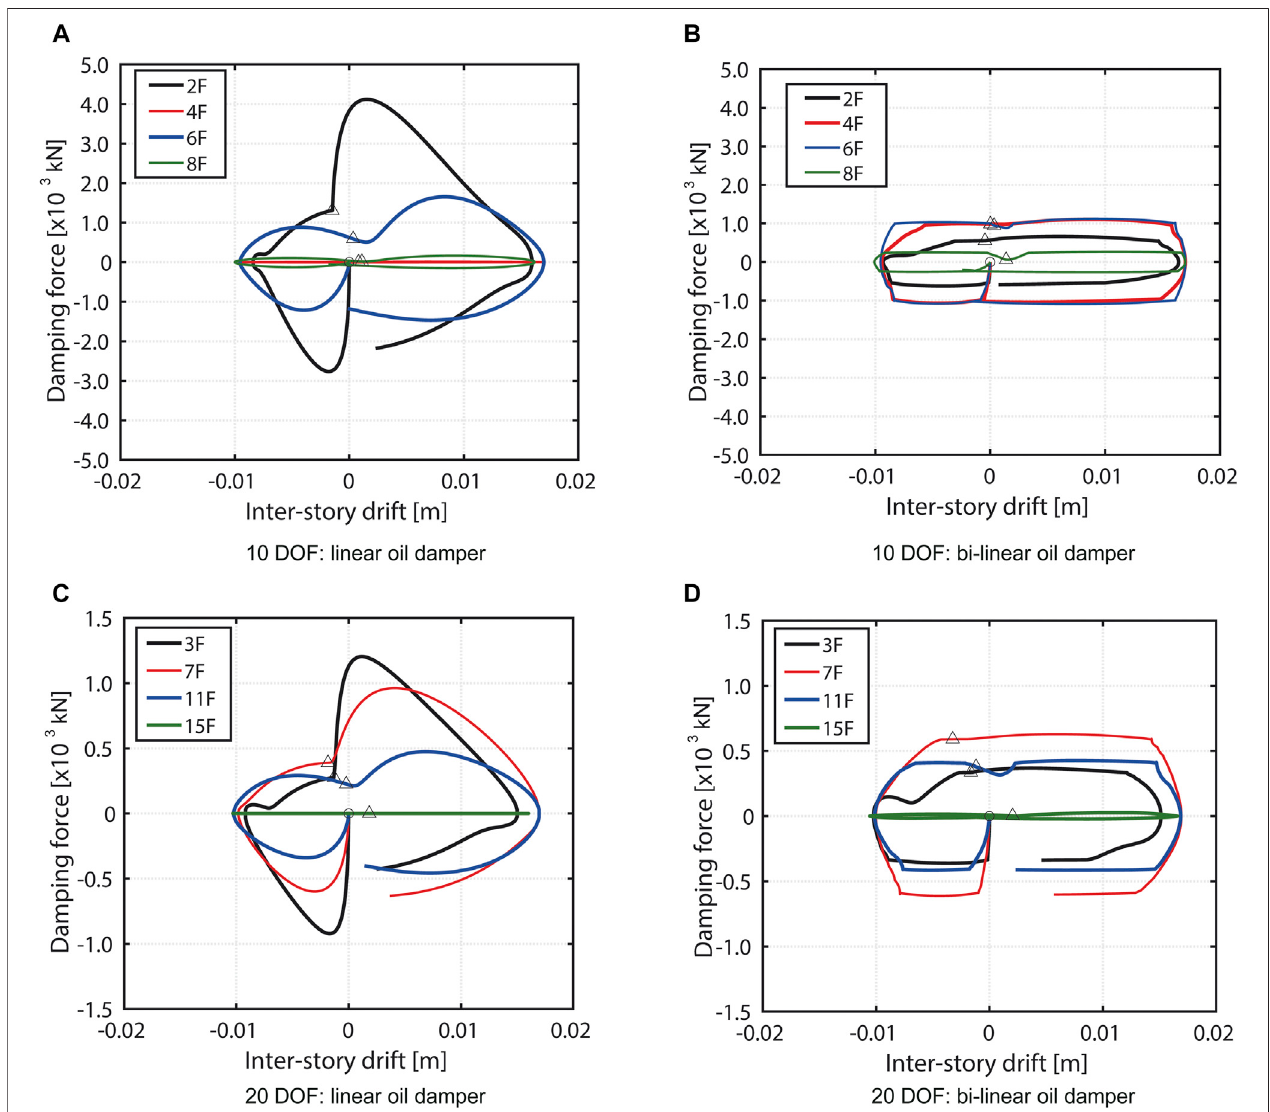
FIGURE 10 | Damping force-interstory drift relations of models designed for linear oil damper and bi-linear oil damper using ordinary optimal design method.